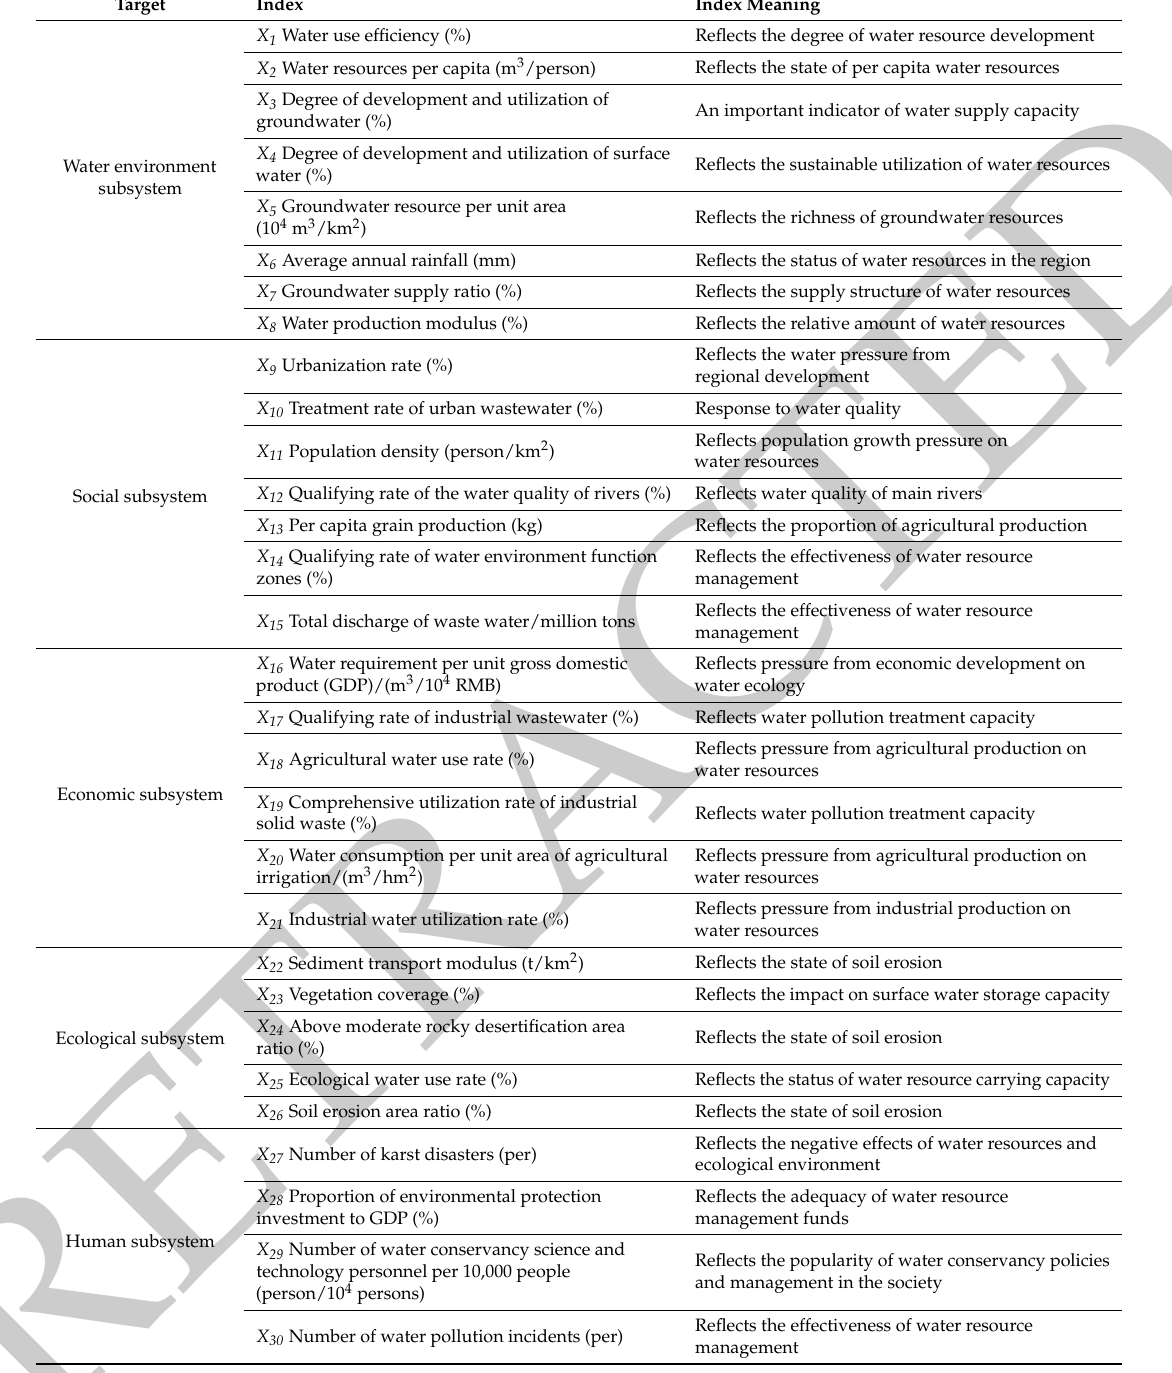
Table 1. Primary evaluation index system of water resource security in karst